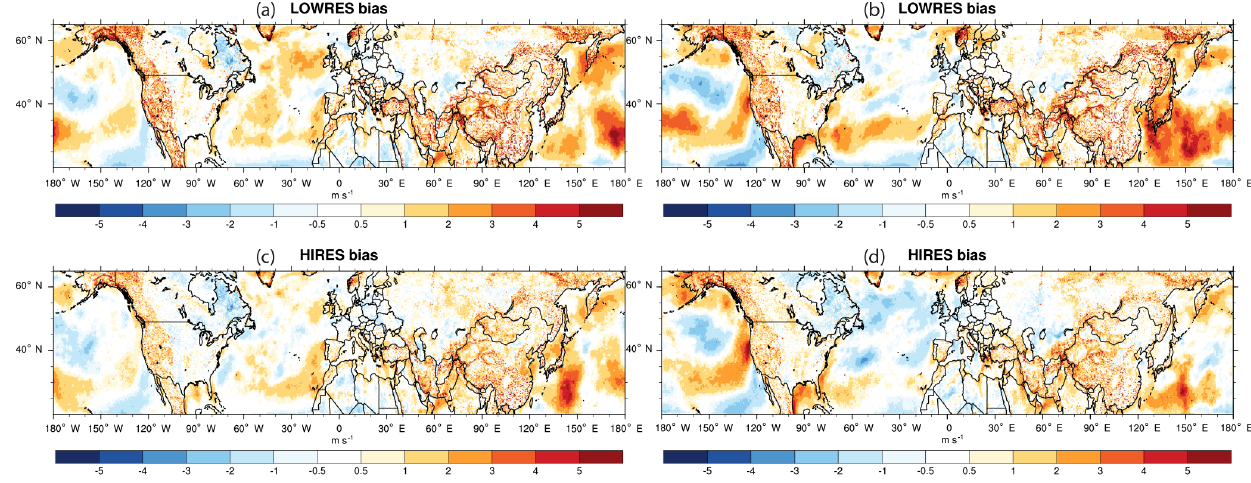
Figure 14. The 10m wind speed bias in July (a, c) and August 2013 (b, d) for the LOWRES simulation (a, b) and the HIRES simulation (c, d)